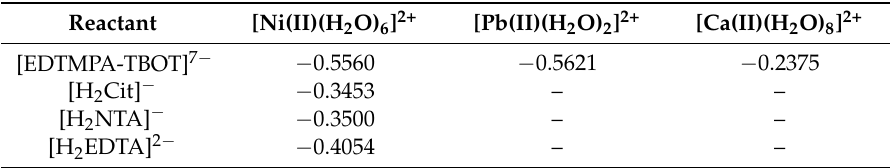
Table 2. ∆ N between the [EDTMPA-TBOT] 7 − ligand and Ni(II), Pb(II) and Ca(II) and that between Ni(II) and citrate, NTA and